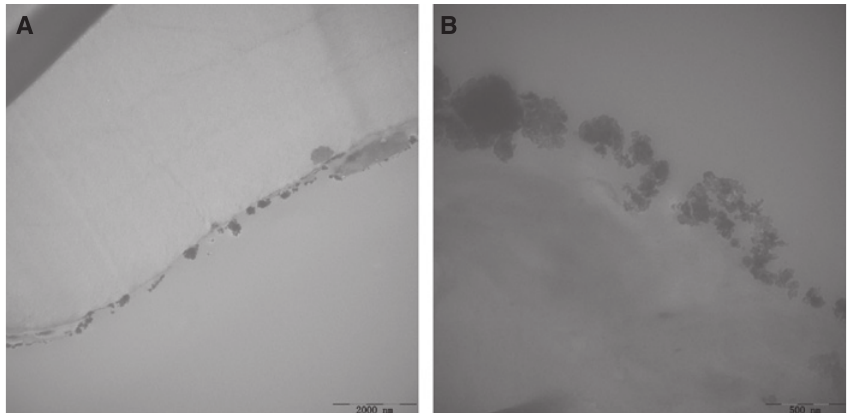
Figure 5: TEM photographs of slice perpendicular to the nanoparticle treated flax fibers, where the black aggregation is the nanoparticles formed. (A) The top right side is flax fiber and the bottom left is the embedding epoxy, (B) the bottom left side is flax fiber and the top right is the embedding epoxy.